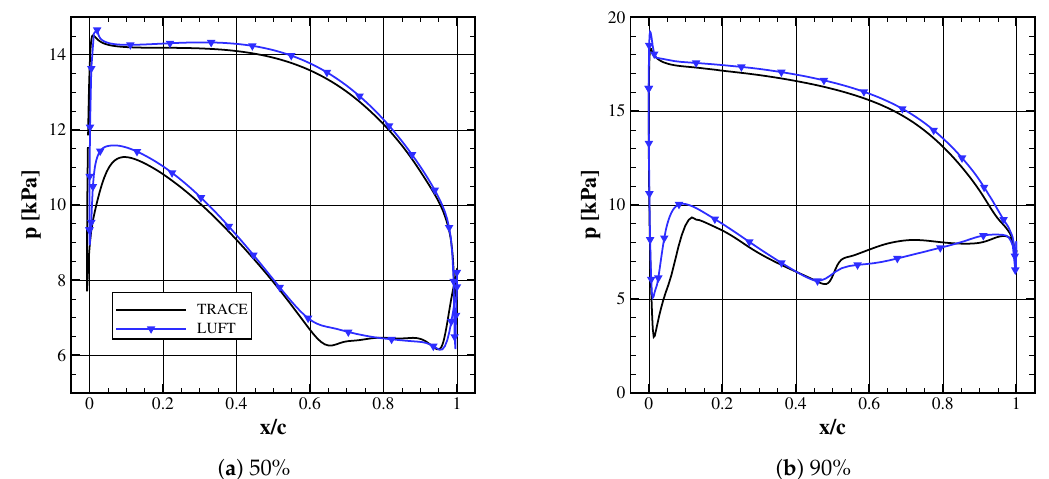
Figure 4. Blade pressure along 50% and 90% channel height.